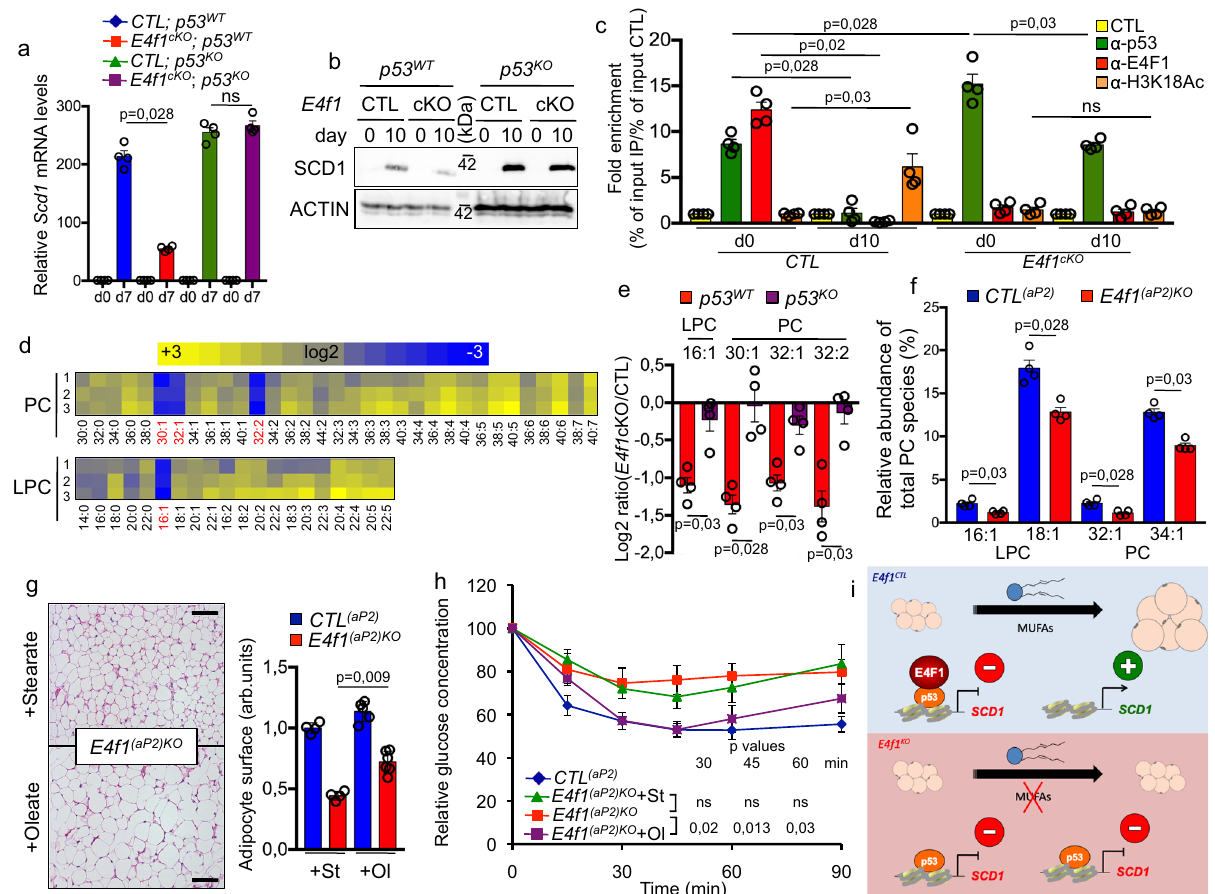
Fig. 7 The E4F1-p53-SCD1 axis plays an important role in the generation of MUFAs and white adipocytes functions. a RT-qPCR analysis of Scd1 mRNA levels in E4f1 cKO or CTL Mefs, and in their p53 KO counterparts, at the indicated time points after induction of adipocyte differentiation ( n = 4 independent populations of cells/group). b Immunoblot analysis of SCD1 and ACTIN (loading control) protein levels in total protein extracts prepared from E4f1 cKO or CTL Mefs and their p53 KO counterparts, at the indicated time points after induction of adipocyte differentiation (data are representative of 3 independent experiments). c Quantitative chromatin immunoprecipitation (qChIP) experiments performed on the Scd1 promoter with anti- E4F1, p53, H3K18ac or control antibodies and chromatin prepared from E4f1 cKO or CTL Mefs, at the indicated time points after induction of adipocyte differentiation. Results are represented as the relative ratio between the mean value of immunoprecipitated chromatin (calculated as a percentage of the input) with the indicated antibodies and the one obtained with a control irrelevant antibody ( n = 4 independent populations of cells/group). d Semi-quantitative analysis of different lysophosphatidycholine (LPC) and phosphatidylcholine (PC) species by ESI-MS-MS in E4f1 cKO and CTL Mefs, 10 days after induction of adipocyte differentiation. The heat maps show the relative abundance of the indicated LPC and PC, expressed as log2 of the ratio of the percentages of total PC between E4f1 cKO and CTL cells. Each lane represents an independent experiment performed on paired samples ( n = 3). e Histobars represent the relative abundance of the indicated PC relevant to SCD1 activity in E4f1 cKO and CTL Mefs, and their p53 KO counterparts (expressed as the log2 ratio of the percentage of total PC between E4f1 CTR and E4f1 cKO cells. n = 3 independent populations of cells/group). f Histobars represent the relative abundance of the indicated PC in BAT harvested from E4f1 (aP2)KO and CTL (aP2) littermates ( n = 4 animals/group). g Representative microphotographs of hematoxylin and eosin (H&E)-stained WATe sections prepared from E4f1 (aP2)KO and CTL (aP2) littermates fed with a tristearin (St) or triolein (Ol)-complemented diet for 3 weeks. Scale bars, 500 μ m. Histobars (right panel) represents the quanti fi cation of adipocyte surface area of WATe from these animals (arb. units, arbitrary units; n = 4 animals/group). h Insulin tolerance test performed on E4f1 (aP2)KO mice and CTL (aP2) littermates, fed with a St or Ol -complemented diet ( n = 7 males/group). i Schematic representation of the roles of E4F1 and p53 on Scd1 regulation during adipocyte differentiation. Molecular weights are indicated in kDa. Data were presented as mean ± standard error mean (SEM) from the indicated number of independent samples. Statistical analyses were performed using two-sided non-parametric Mann – Whitney U tests and the BiostaTGV software (ns, not signi fi cant). Source data are provided as a Source Data fi